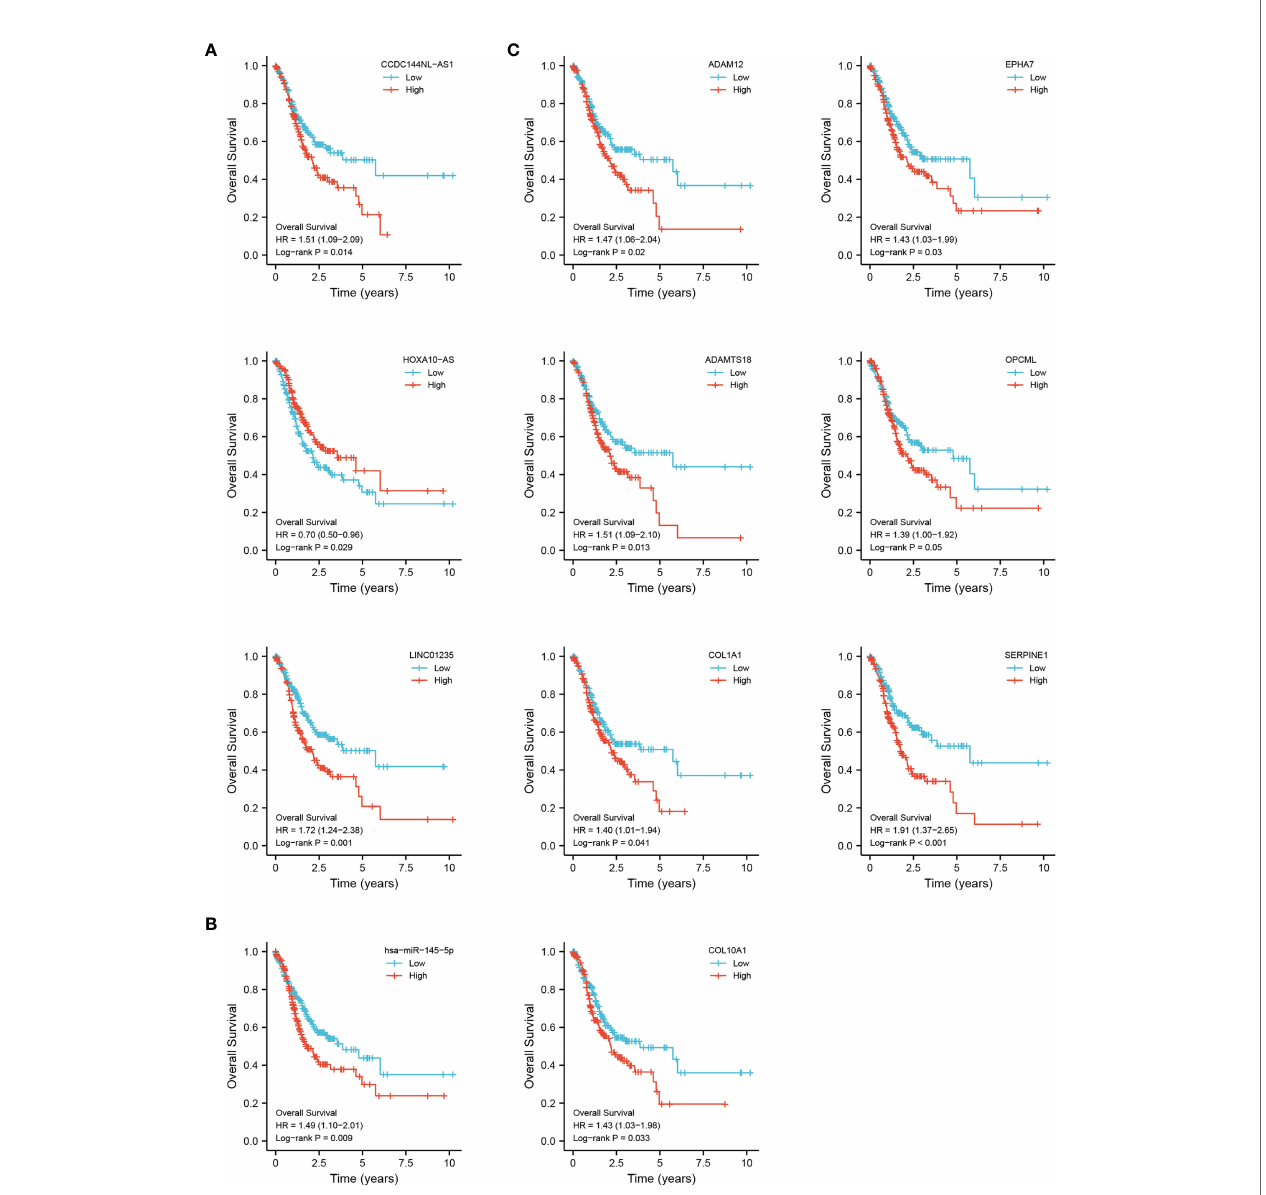
FIGURE 3 | Overall survival analysis for the DEGs in the triple regulatory network. The high-expression and low-expression values of 11 survival-related genes were compared by a K-M survival curve for TCGA STAD patient cohort. (A) 3 DElncRNAs. (B) 1 DEmiRNA. (C) 7 DEmRNAs. The horizontal axis indicates the overall survival time in years, and the vertical axis represents the survival